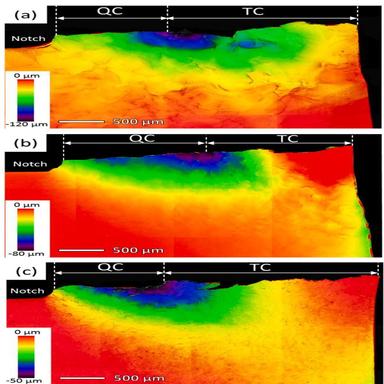
The height maps obtained by CLSM from the side surfaces of the technically pure iron – (a), Fe-2.5%Si alloy – (b) and low-carbon steel S235JR – (c) specimens.